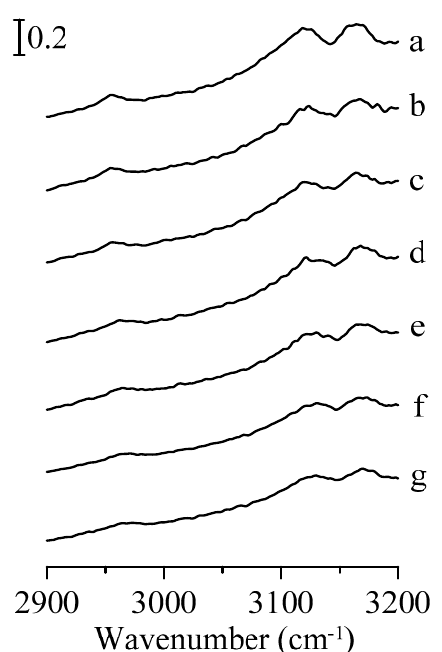
Figure 2. Infrared spectra of the Al 2 O 3 /1,3-dimethylimidazolium methyl sulfate mixture obtained under ambient pressure (curve a) and at 0.4 (curve b), 0.7 (curve c), 1.1 (curve d), 1.5 (curve e), 1.8 (curve f), and 2.5 GPa (curve g).